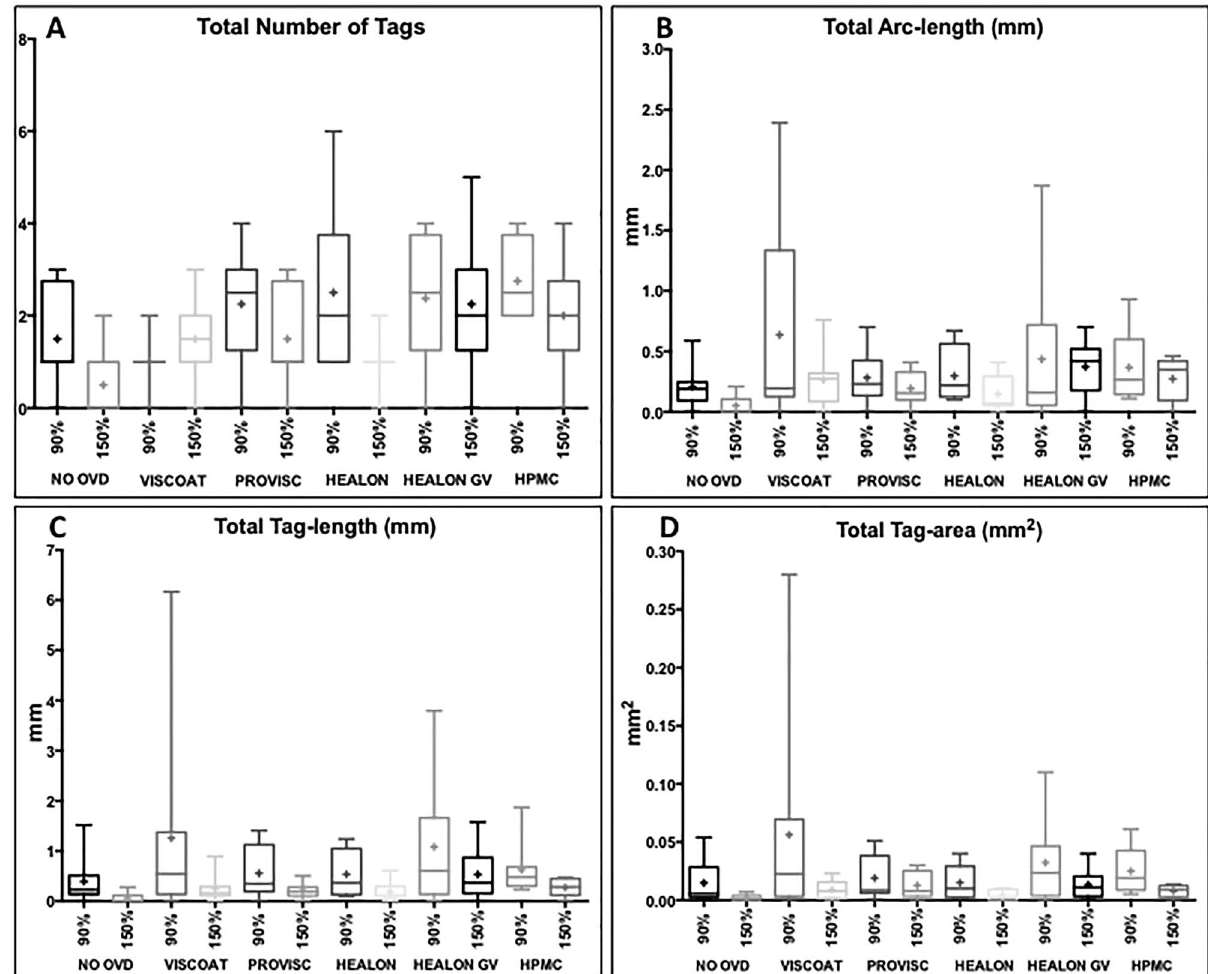
Figure 3. Comparison of total number of tags, total arc-length, total tag-length and total tag-area in sub- groups, with 90% and 150% energy settings. ( A – D ) The box and whisker plots showing variability in the plotted data for the total number of tags, total arc-length, total tag-length and total tag-area, respectively. A higher energy setting (150%) reduced the total number of tags, decreased the total arc-length and total tag-length, as well as reduced the total tag-area, respectively, across the sub-groups. The ‘mean’ is represented by a ‘+’ in the box plots. The box extends from the 25th to 75th (p = 0.001), during the laser treatment. The occurrence of a large tag, as well as a clinically significant tag, was independent of the type of an OVD used, with both 90% (p = 0.98 and p = 0.44 respectively) and 150% energies (p = 0.26 and p = 0.40 respectively).